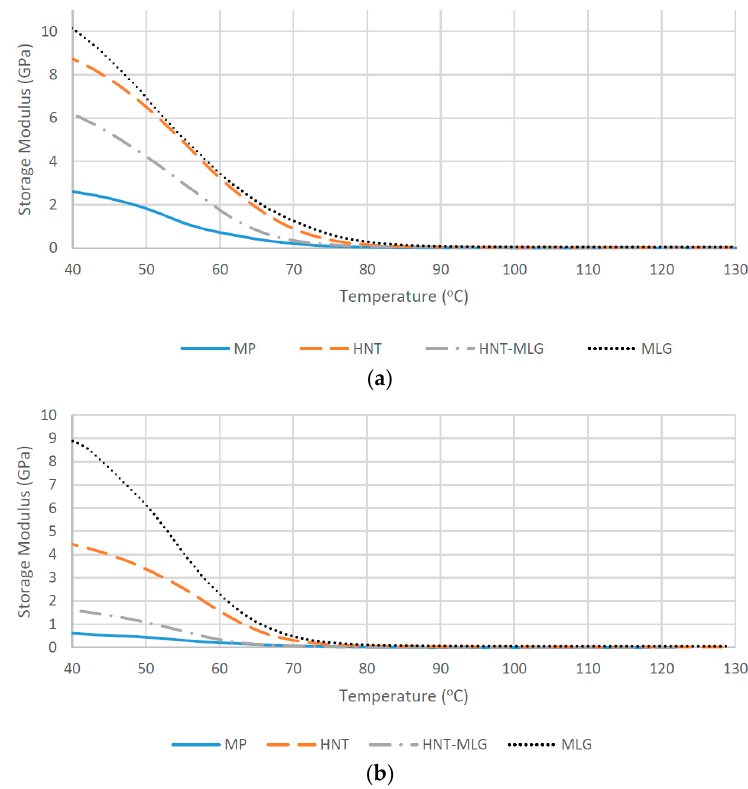
Figure 4. Storage modulus of nanocomposites in dry conditions ( a ) and after water exposure ( b ).